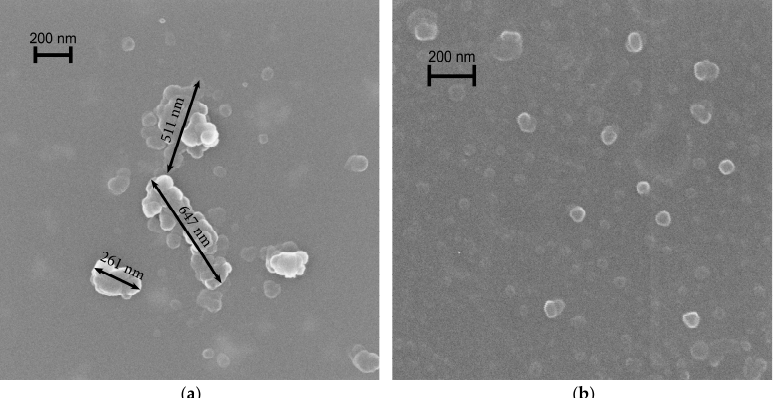
Figure 4. SEM image of particle dispersion for ( a ) System I ( d av = 46 nm, 1 wt. % TiO 2 ); and ( b ) System II ( d av = 100 nm, 1 wt. % TiO 2 ).